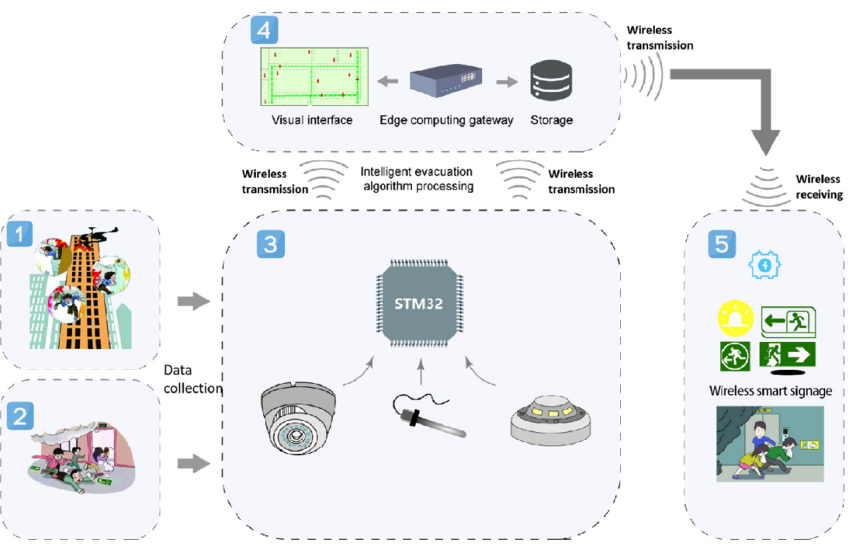
Figure 1. system architecture and operation procedure. Figure 1. System architecture and operation procedure.